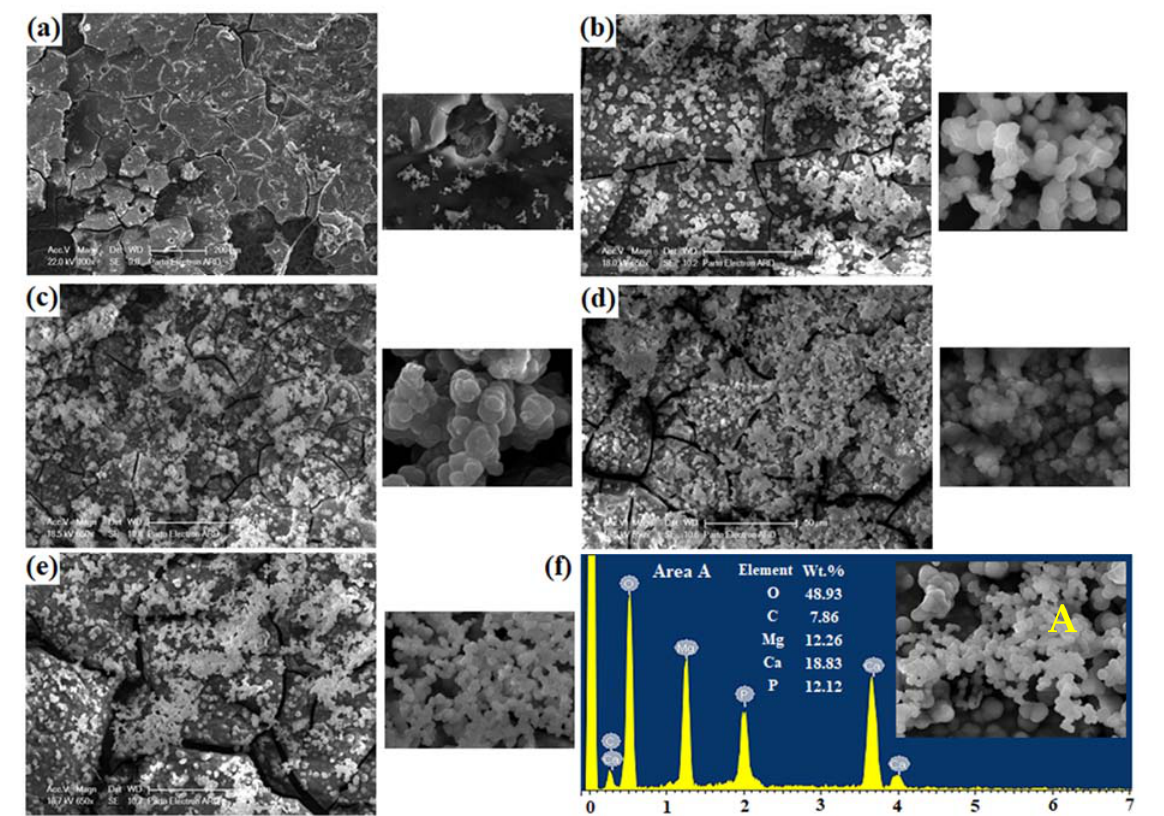
Figure 8. SEM micrographs and EDS plane-scan results of ( a ) uncoated, ( b ) CS, ( c ) CS/1MgO-GO, ( d ) CS/2MgO-GO, and ( e ) CS/3MgO-GO coated Mg samples immersed in m-SBF solution for 7 days and ( f ) EDX analysis of Area A.